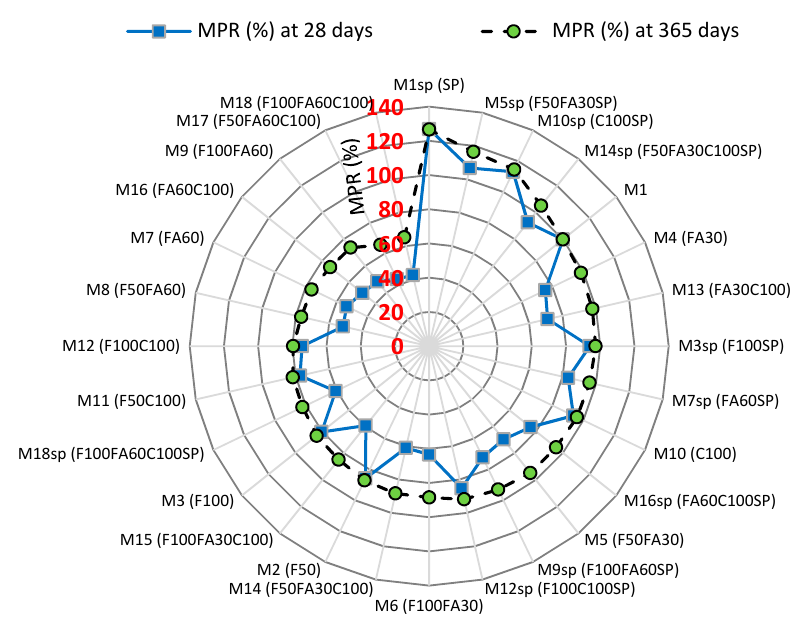
Figure 3. Ranking the concrete mixes based on the mechanical performance ratio (MPR) at 28 and 365 days.